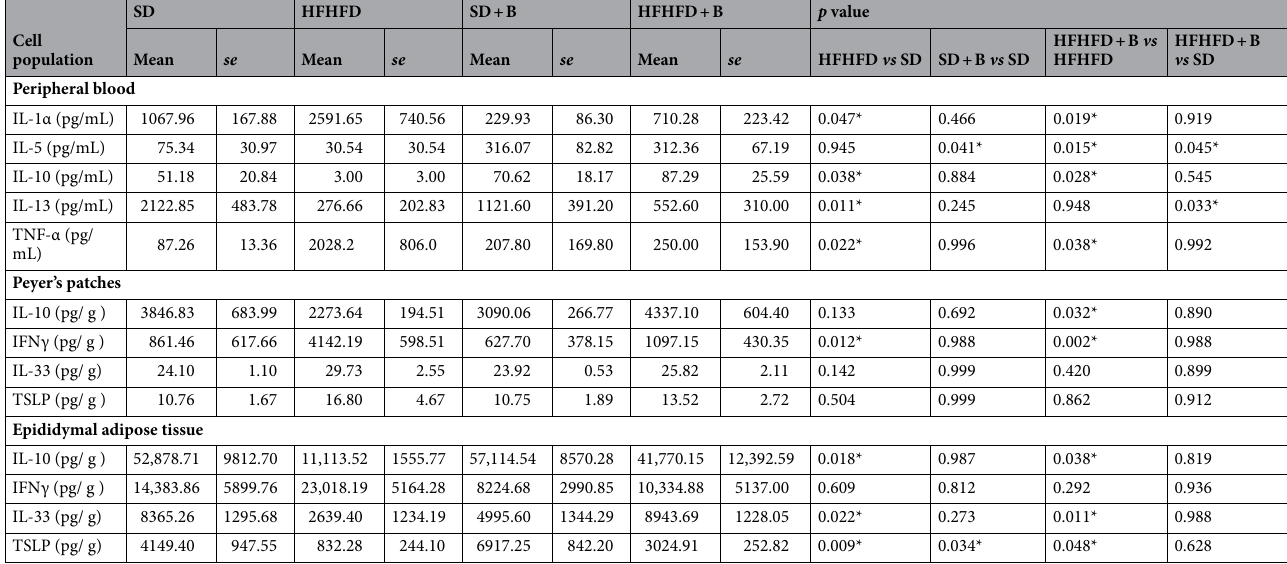
Table 2. Effects of Bacteroides uniformis CECT 7771 on cytokine concentrations in plasma and tissues from mice in all experimental groups. SD group: control mice received a standard diet (SD) plus placebo; HFHFD group: obese mice received a high-fat high-fructose diet (HFHFD) plus placebo; SD + B group: control mice received a SD and a daily dose of 1 × 10 8 CFU Bacteroides uniformis CECT 7771; HFHFD + B group: obese mice Data are expressed as mean and standard error ( se ) of each mouse group (n = 10 per group). *Significant differences were established by ANOVA and post hoc student t test ( p <